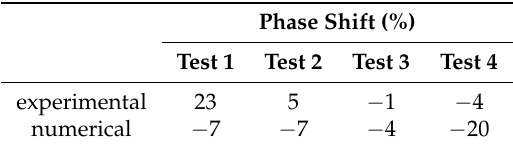
Table 6. Numerical and experimental results for the phase shift (expressed in percentage of the period) between wind speed and rotor speed.